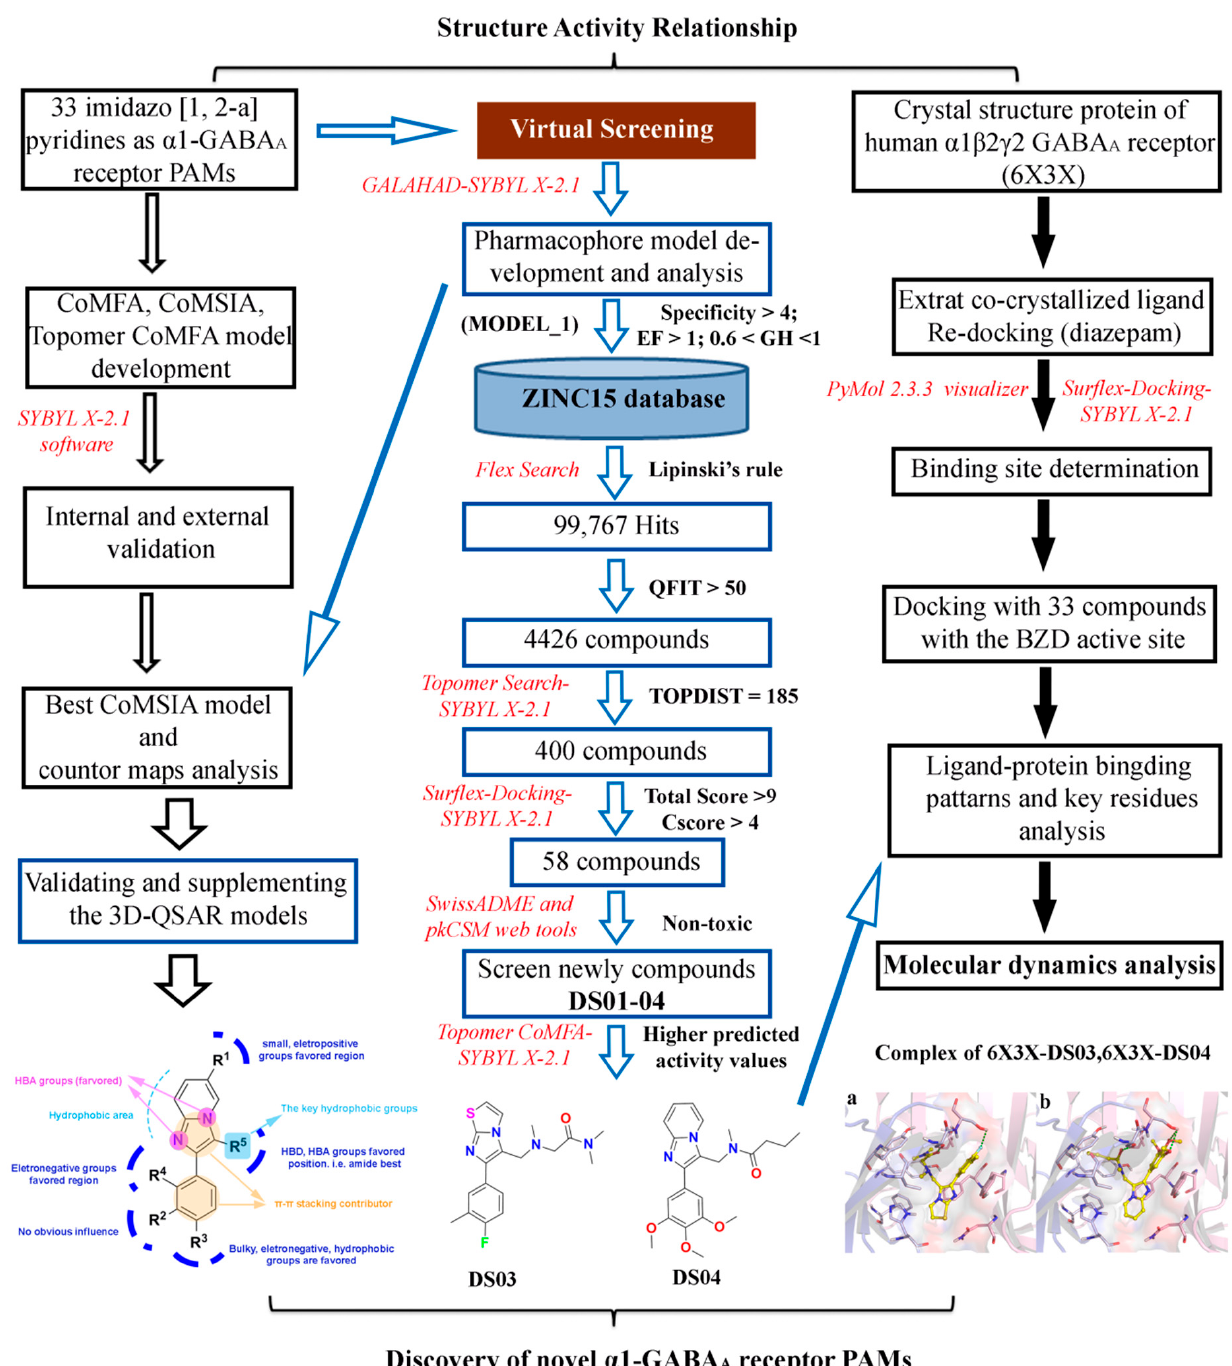
Figure 2. Flow chart of computational drug design for the discovery of novel α 1-GABA A R PAMs (the used softwares are marked with red italics).